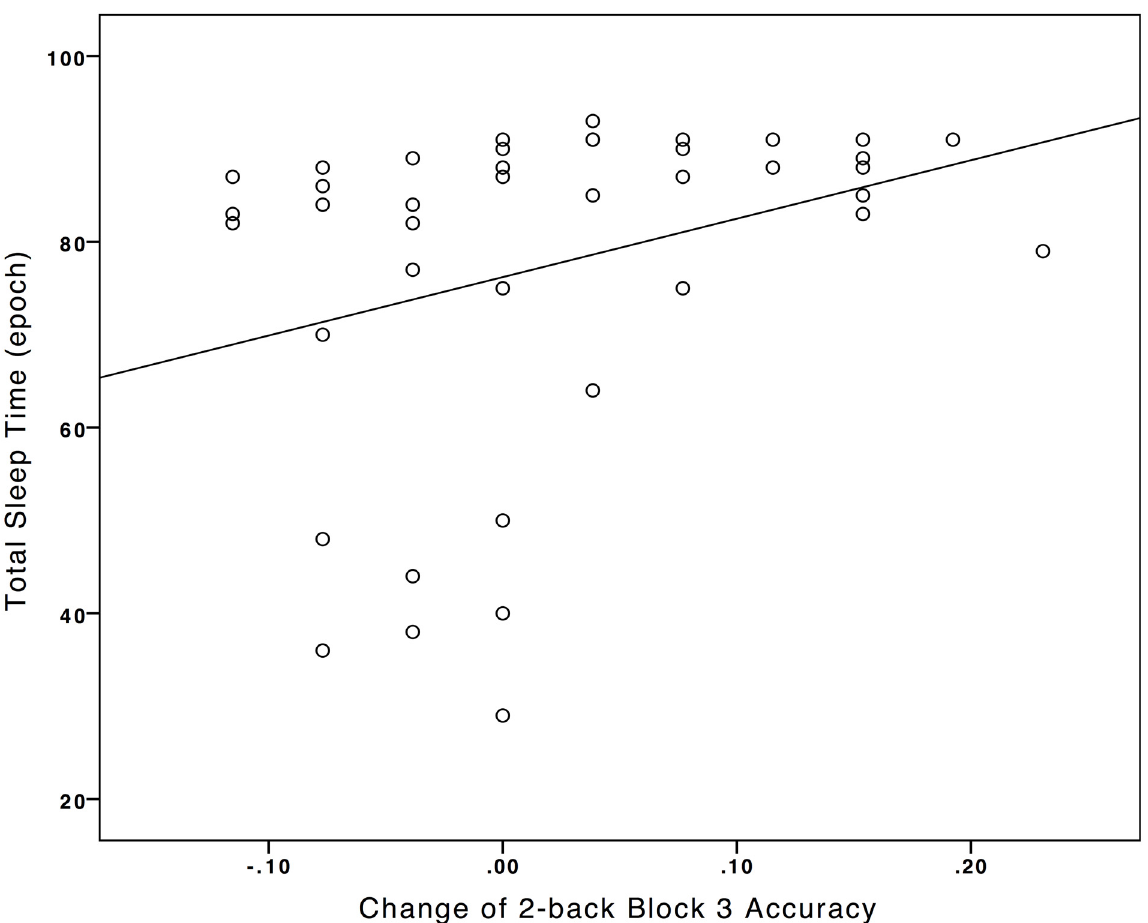
Fig 2. Association between total-sleep-time during napping with the pre/post-condition difference of 2-back Block 3